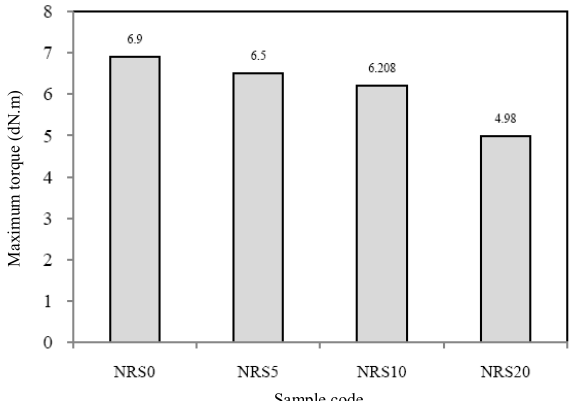
Figure 3 . Maximum torque of samples at various silica